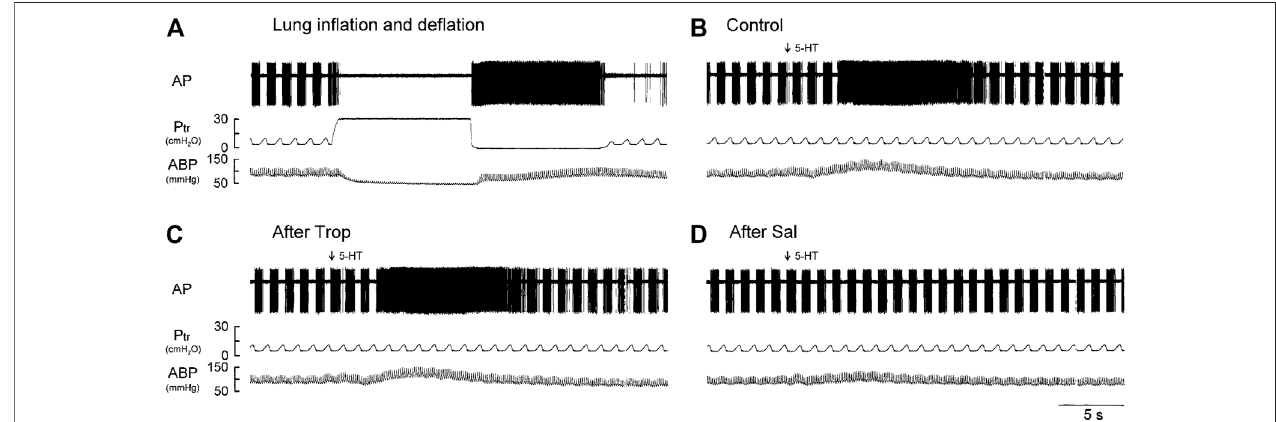
FIGURE 1 | Experiment records illustrating the responses of a phasic RAR located in the right lower lobe in an anesthetized, vagotomized, open-chest, and mechanicallyventilatedrat(405 g)to: (A) lungin fl ationgeneratedbyaconstantP tr heldat30cmH 2 Ofor10 s,followedimmediatelybylungde fl ation(P tr =0cmH 2 O,held for10 s); (B – D) i.v.injectionsof5-HT(16 μ g/kg)before,15 minafterpretreatmentwithTrop(15 μ g/kg),and10 minafterpretreatmentwithSal(0.5 mg/kg),respectively. 5-HT (0.1 ml) was fi rst slowly injected into the catheter and then fl ushed (marked by arrow) as a bolus with vehicle (isotonic saline, 0.3 ml). At least 15 min elapsed between two injections of 5-HT to avoid possible tachyphylaxis. AP, action potential; P tr , tracheal pressure; ABP, arterial blood pressure.